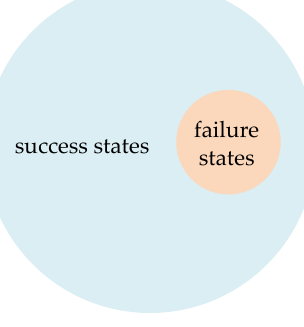
Figure 3. The constituents of the system state space.